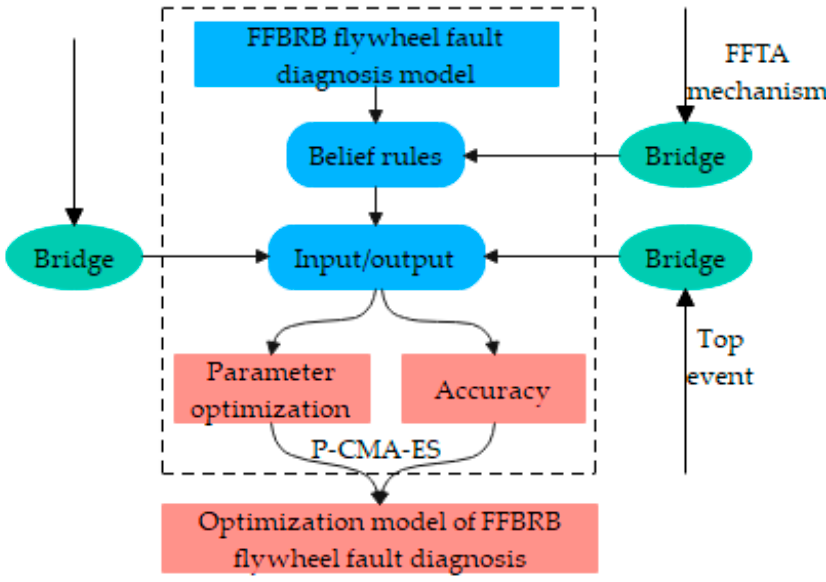
Figure 1. Fault diagnosis schematic diagram of FFBRB model.